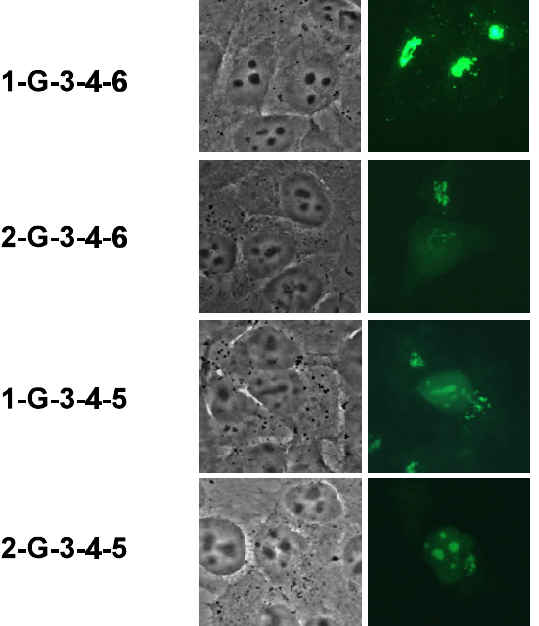
Figure 3 Localization of full-length chimeric proteins. The field were imaged by phase contrast (left column) or fluorescence (right column) microscopy. The identity of the chimeras is given on the